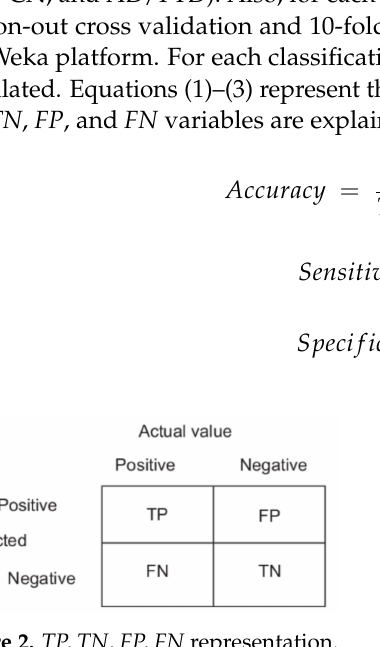
Figure 2. TP, TN, FP, FN